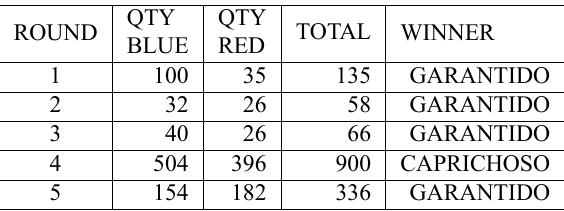
Table 4. Interaction round table during Carnaboi